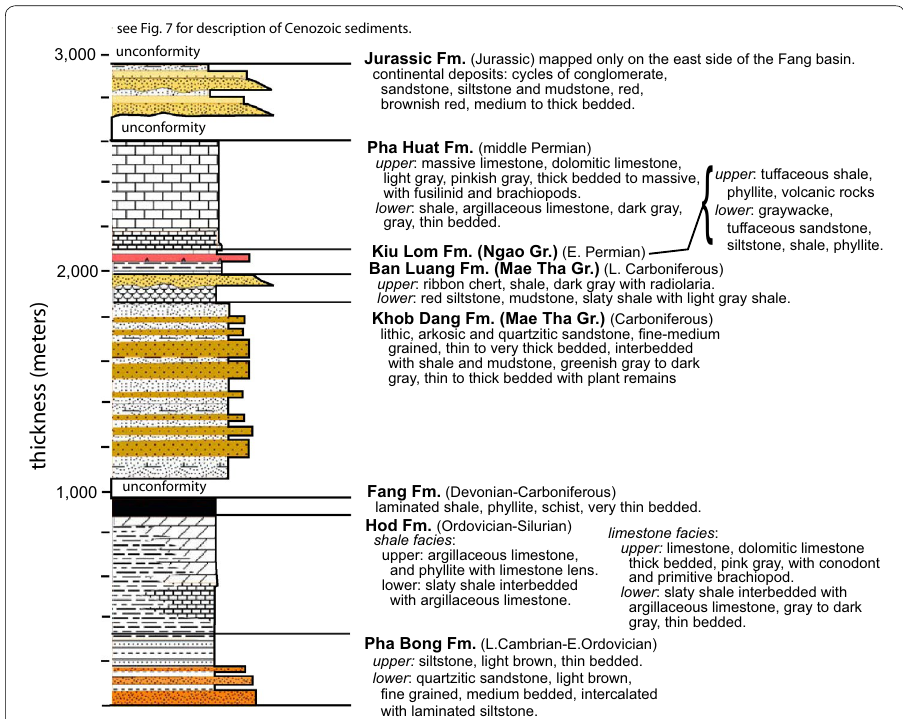
Fig. 11 Stratigraphic column of Paleozoic rocks from Imsamut and Krawchan (2005) based on their mapping of the Amphoe Fang (4848 IV) and Doi Pha Wok (4748 I) map